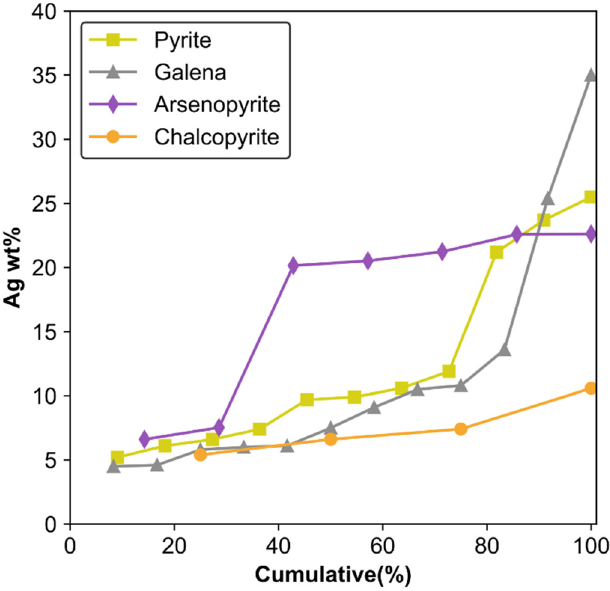
Figure 9. SEM-EDS silver contents in native gold particle cores hosting most commonly observed ore mineral inclusions. Arsenopyrite appears to be more abundant in high-silver–low fineness (>15 Ag wt%) particles, while galena, pyrite and chalcopyrite are more likely to be found in low-silver–high fineness (<15 Ag wt%) particles.